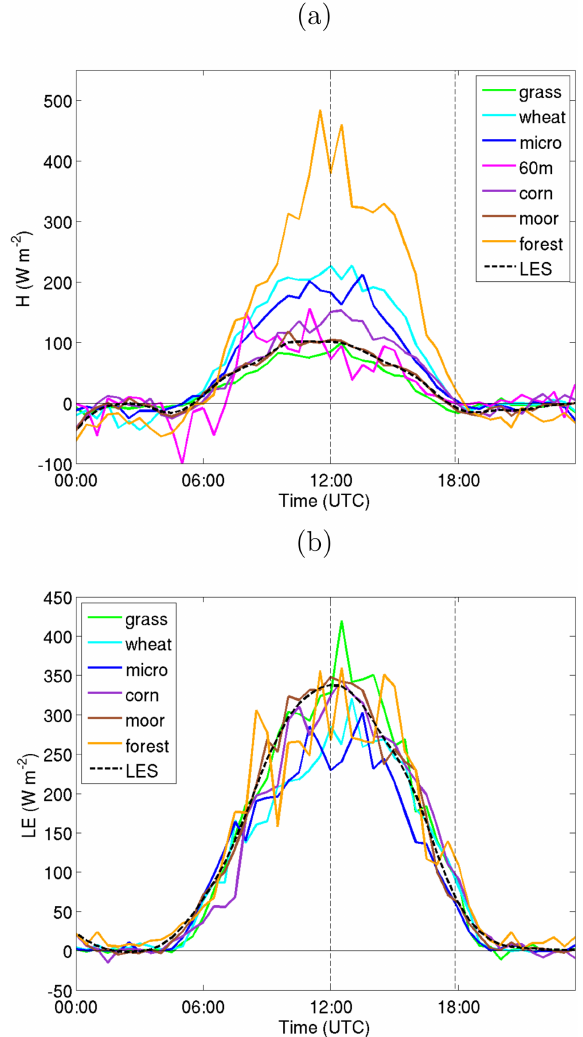
Figure 3. Temporal evolution of (a) surface sensible ( H ) and (b) latent (LE) heat fluxes over several vegetation coverages on 20 June 2011. Dashed black curves stand for the surface flux used as bound- ary conditions for the LES. The vertical dashed lines stand for the times of maximum surface buoyancy flux (at 12:00UTC) and zero value (at